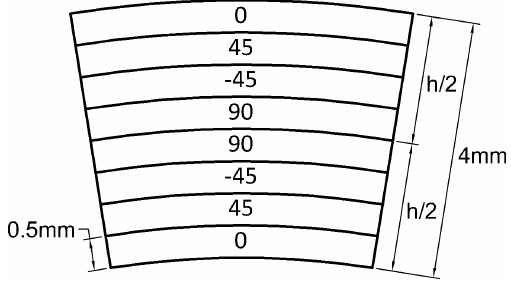
Figure 9. Quasi-isotropic